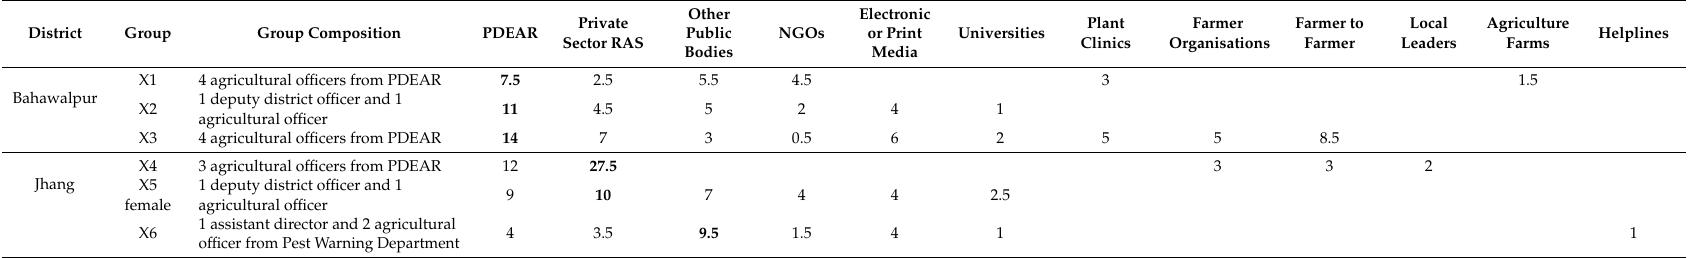
Table 5. Interaction scores between stakeholders in a Rural Advisory Service (RAS) network in a PW and non-PW district administration. District Group Group Composition PDEAR Private Sector RAS